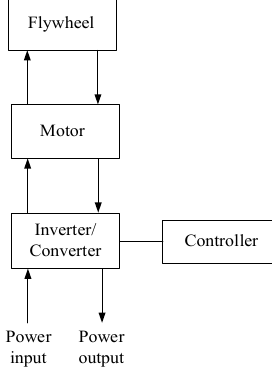
Fig. 4. Working principle diagram of